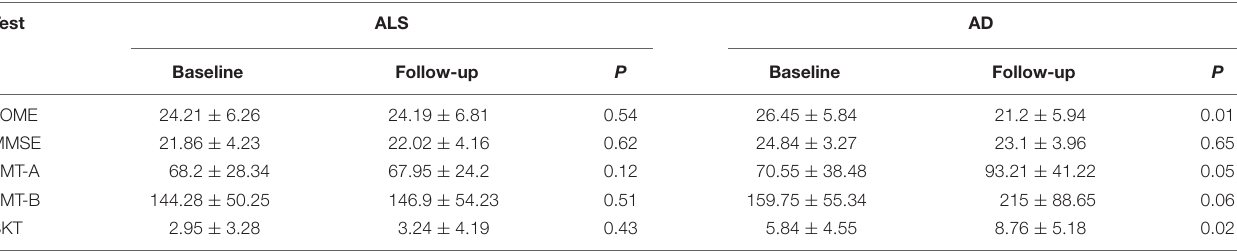
TABLE 2 | Neuropsychological performances of AD and ALS patients.